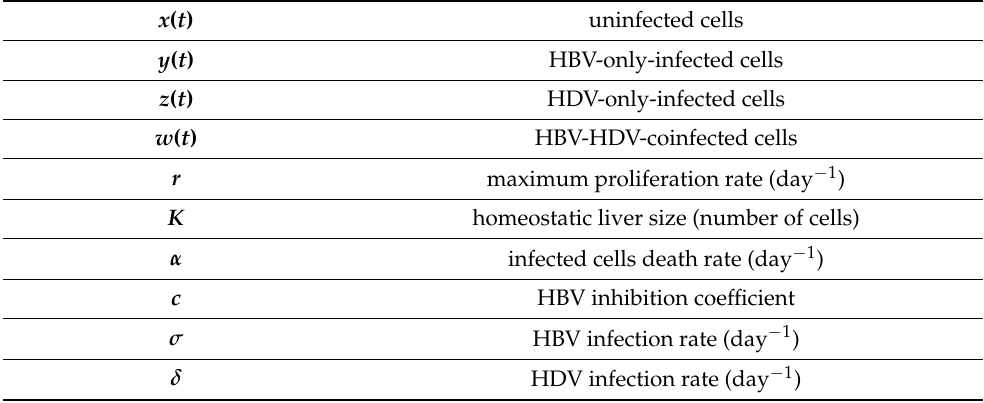
Table 2. The variables and the parameters in the model of Packer et al. [6]. x ( t ) uninfected